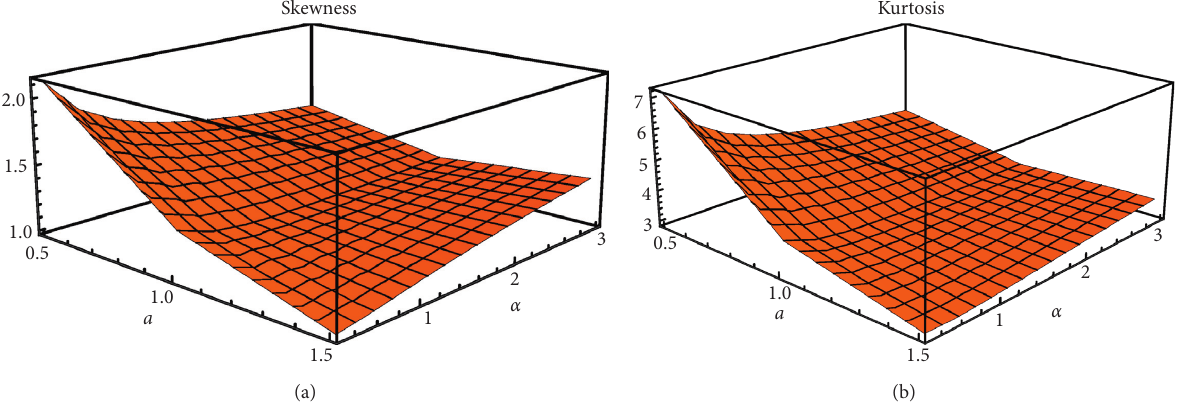
Figure 3: Plots of the skewness and kurtosis for the APTIL